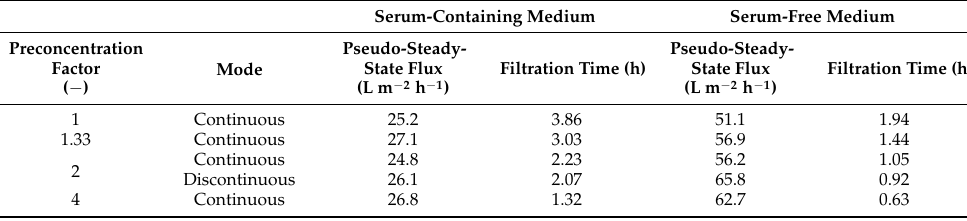
Figure 3. Flux decline in relation to different pre-concentration factors for MV in ( a ) SCM and ( b ) SFM. For continuous diafiltration, the data represent pre-concentration factors of 1 (yellow), 1.33 (blue), 2 (green) and 4 (red). For discontinuous diafiltration, the pre-concentration factor of 2 is represented by open diamonds [37]. Table 2. Overview of steady-state fluxes and filtration times in relation to pre-concentration factors. For all processes, we applied rebuffering with 5 diavolumes and an overall process concentration factor of 8. For the pre-concentration factor of 2, we tested both continuous and discontinuous modes of diafiltration